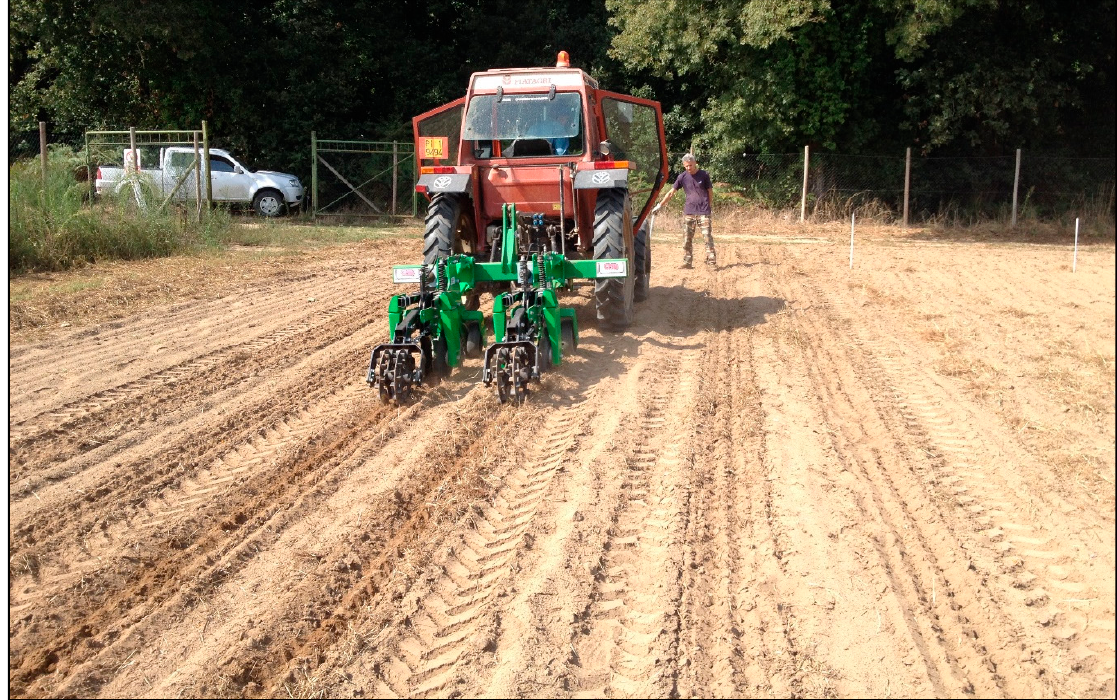
Figure 3. Prototype of a strip tiller realized by CMA Machine Agricole srl tested at the University of Pisa.